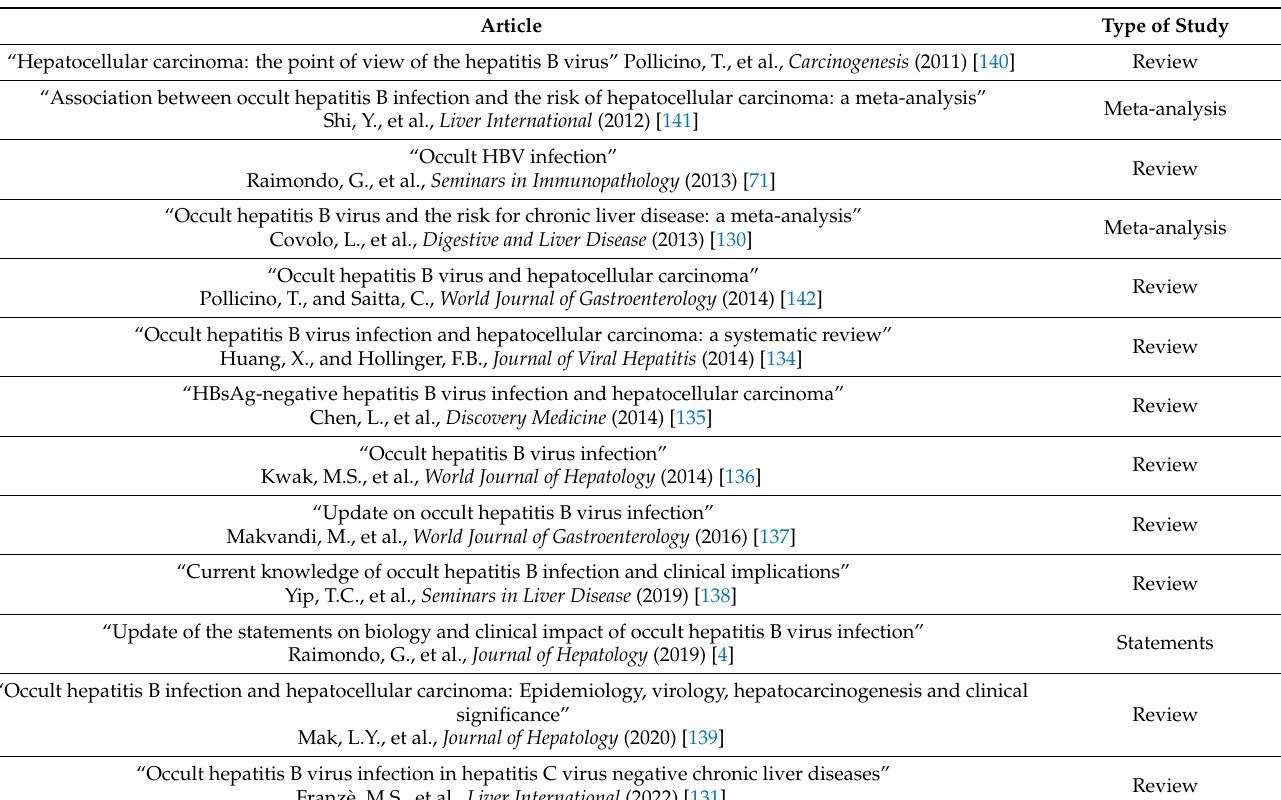
Table 1. Selection of reviews, meta-analyses, and statements concerning the relationship between occult hepatitis B virus infection and cirrhosis/hepatocellular carcinoma published since